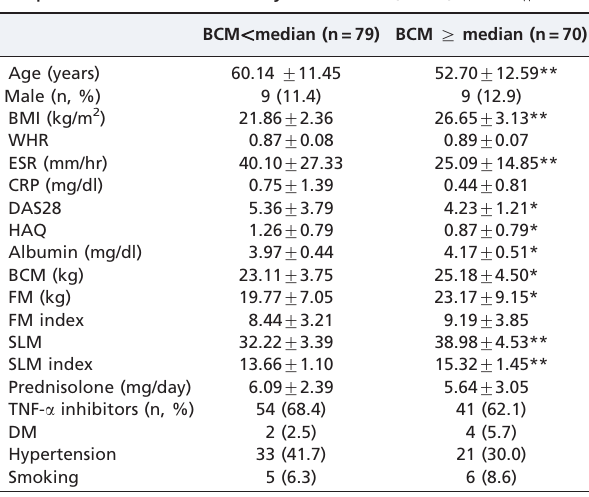
Table 2 - Comparison of clinical characteristics, anthropometric measurements and body compositions of RA patients with diffebody cell mass (BCM) levels # .